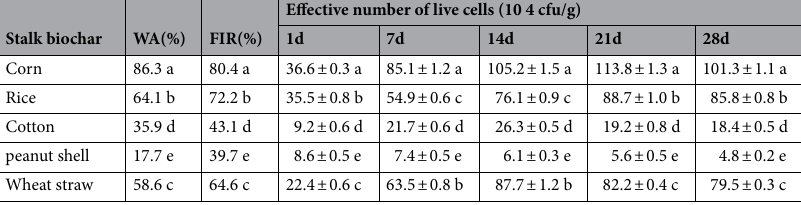
Table 2. Adsorption stability of different carrier materials. WA water absorption, FIR fungal inhibition